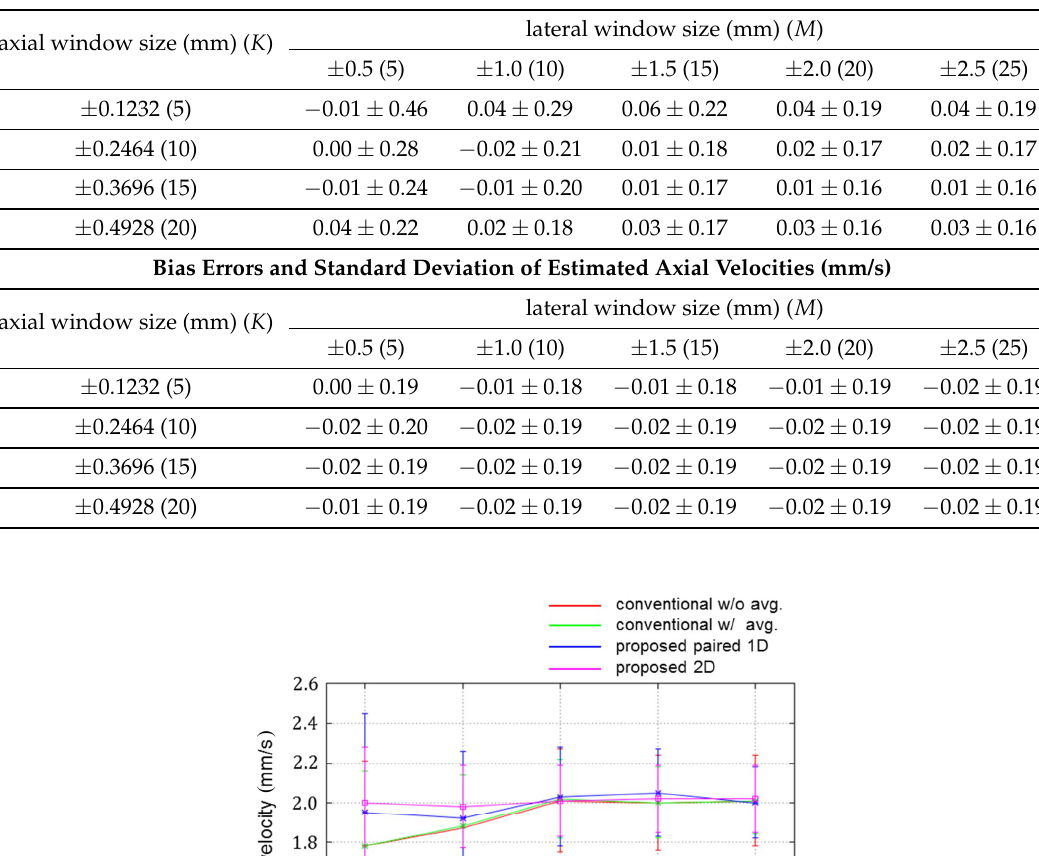
Table 4. Bias errors e bias and standard deviations σ of lateral and axial displacements at nine red points in Figure 4a estimated by the proposed 2D motion estimator with frame averaging. Beamformed echo signals were obtained with rectangular apodization. Actual lateral and axial velocities were 2 mm/s and –1 mm/s, respectively.